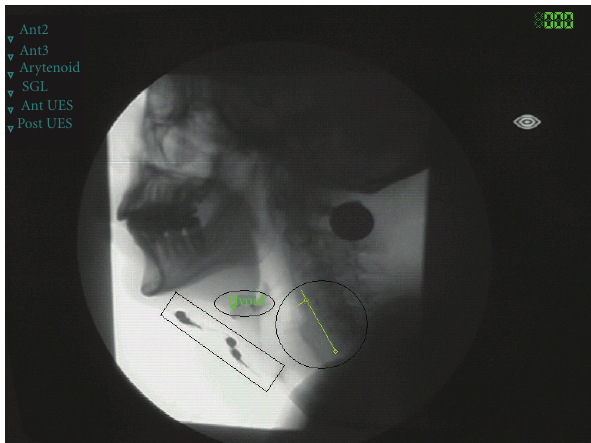
Figure 1: Single frame of the videofluoroscopic recording showing the landmarks used for spatial measurements. Extent of movement of the hyoid bone in the x - y coordinate system. The square encloses four electrodes in position during status “electrical current o ff ,” the oval includes the marked hyoid bone, and the circle indicates the x - y coordinate